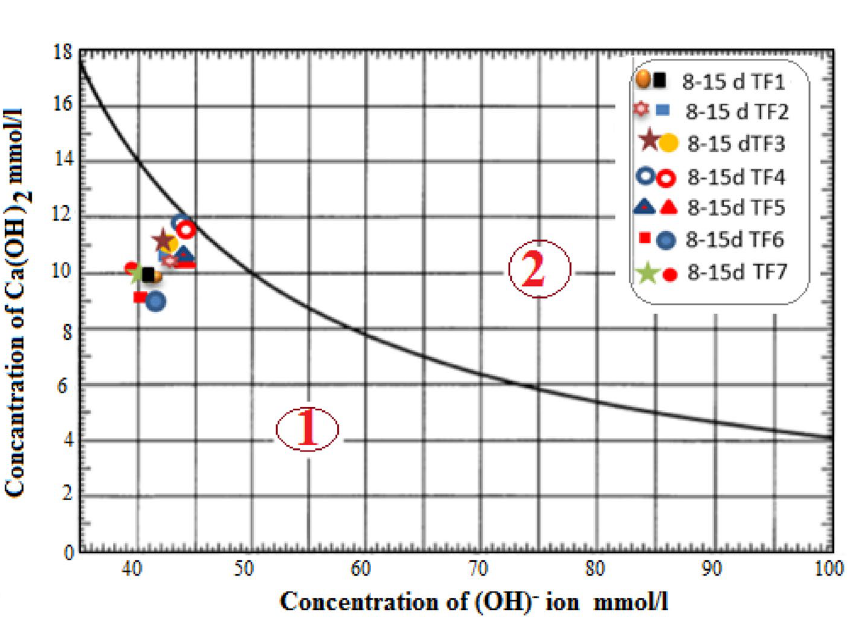
Figure 3. Variation of the pozzolanic features of Tuff samples at 8 and 15